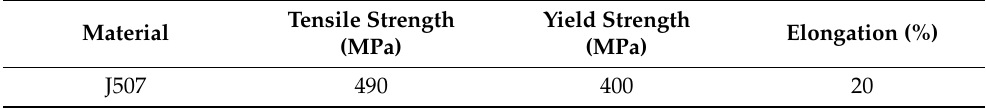
Table 2. Mechanical parameters of welding electrodes.